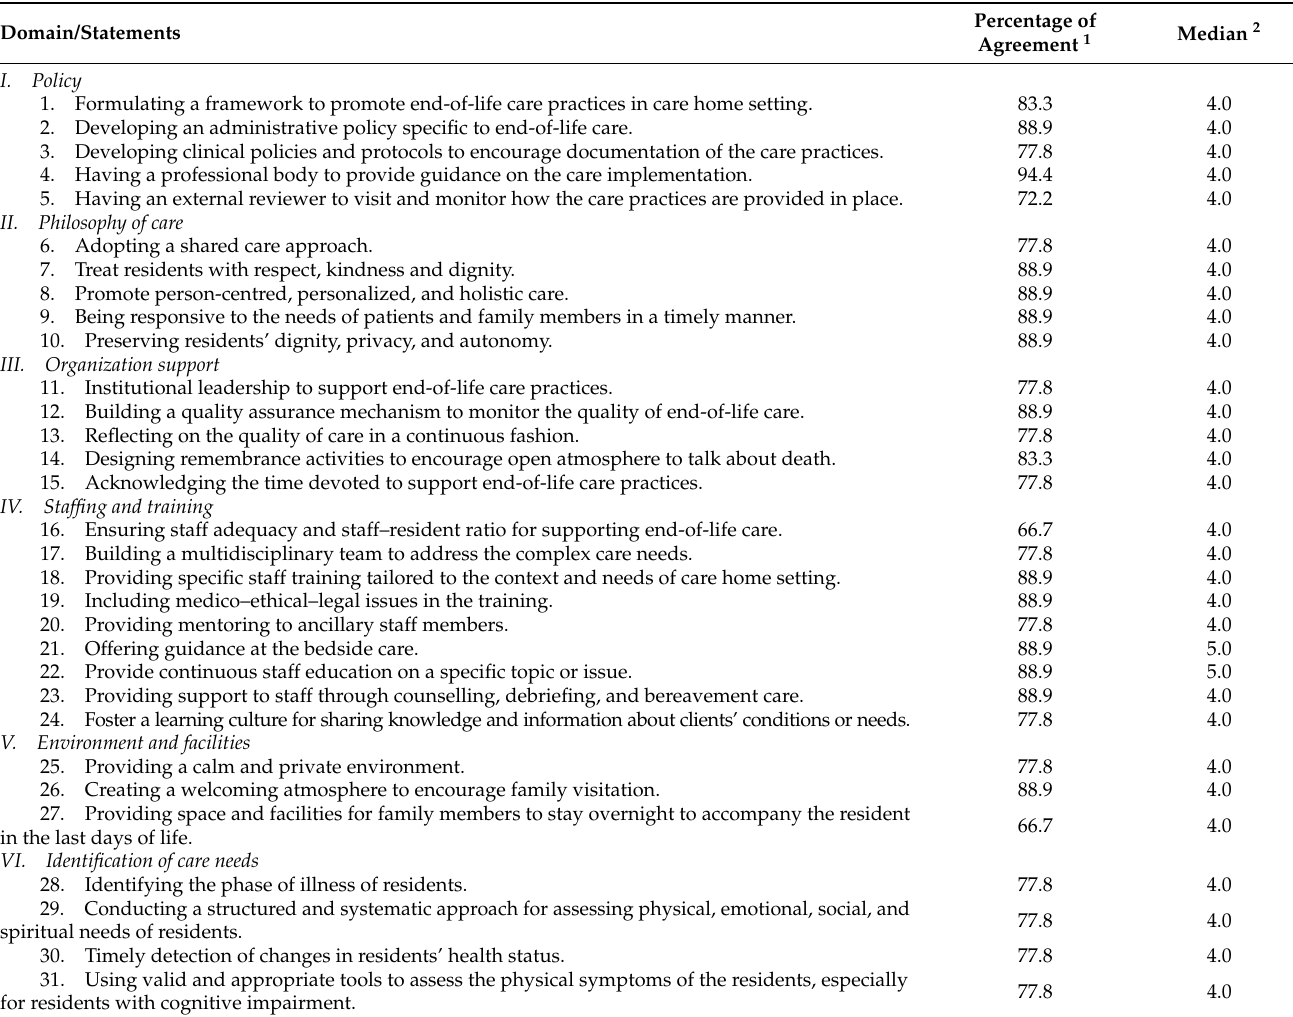
Table 1. Findings of the round 1